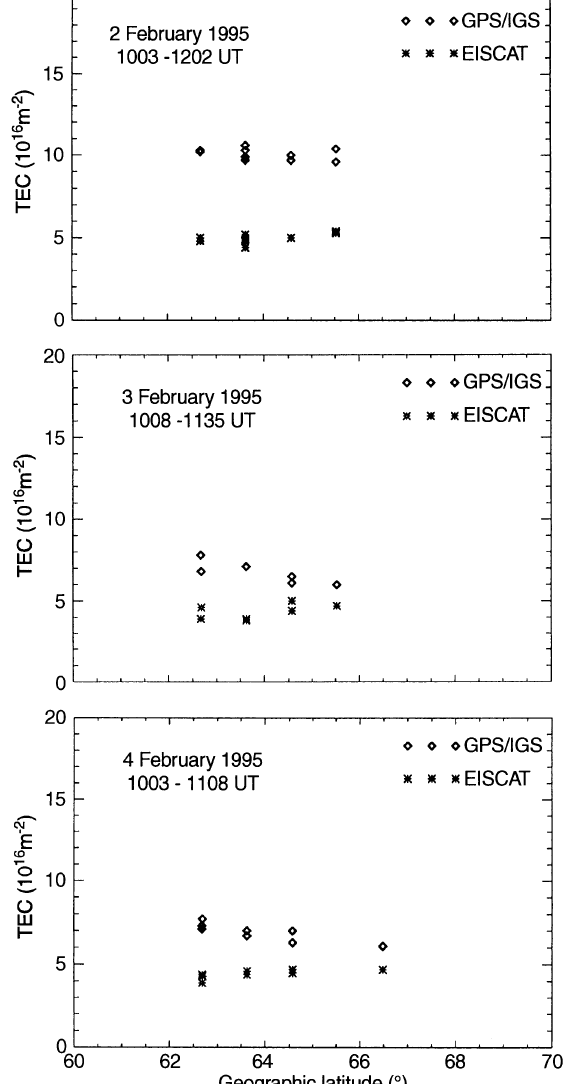
Fig. 6. Comparison of integrated and vertically mapped EISCAT CP3 data and TEC data derived from GPS measurements within 15-min time-intervals and 5 ° distance ranges between EISCAT and GPS measuring points